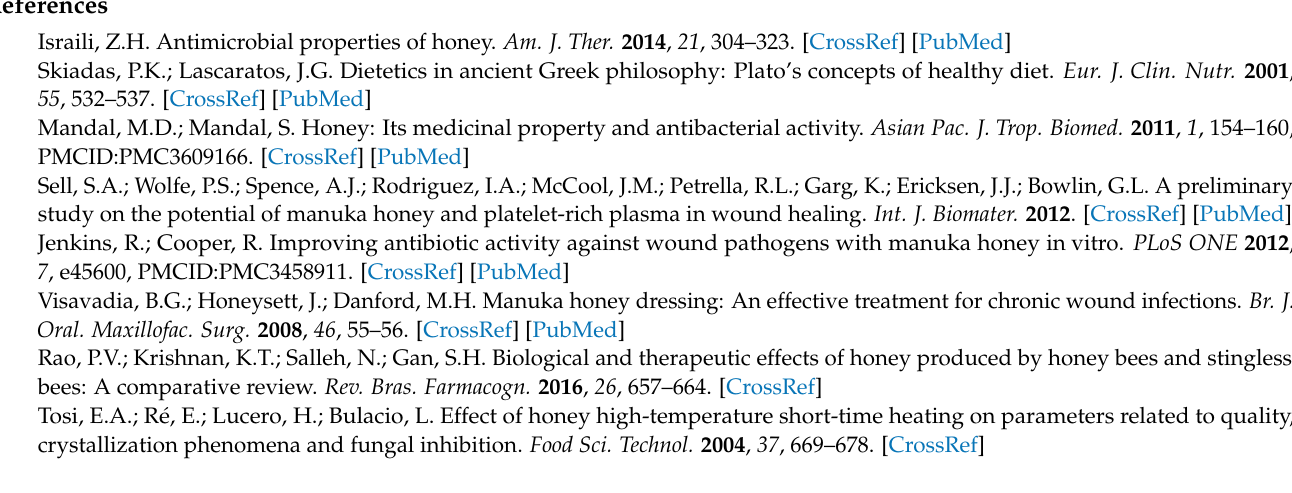
Table S5: Urease Inhibitory effect of pure and diethyl ether extracts of oregano honey against two H. pylori strains isolated from ulcers ( Hp U1, Hp U2) and the reference strain DSM21031, Figure S1: Mean diameter of inhibition zones from various solvent extracts against ulcer ( Hp U1-6, n = 6), gastritis ( Hp G1-8, n = 8), and the reference strain of H. pylori DSM21031, Figure S2: MIC 95 values (% v / v ) of h -hexane, diethyl ether, chloroform, and ethyl acetate oregano honey extracts against (6) H.